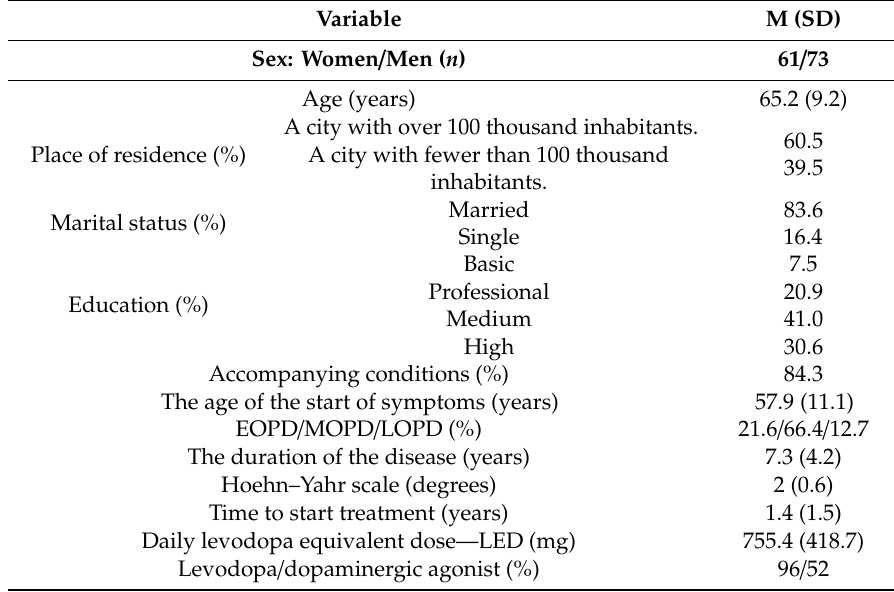
Table 1. Characteristics of the